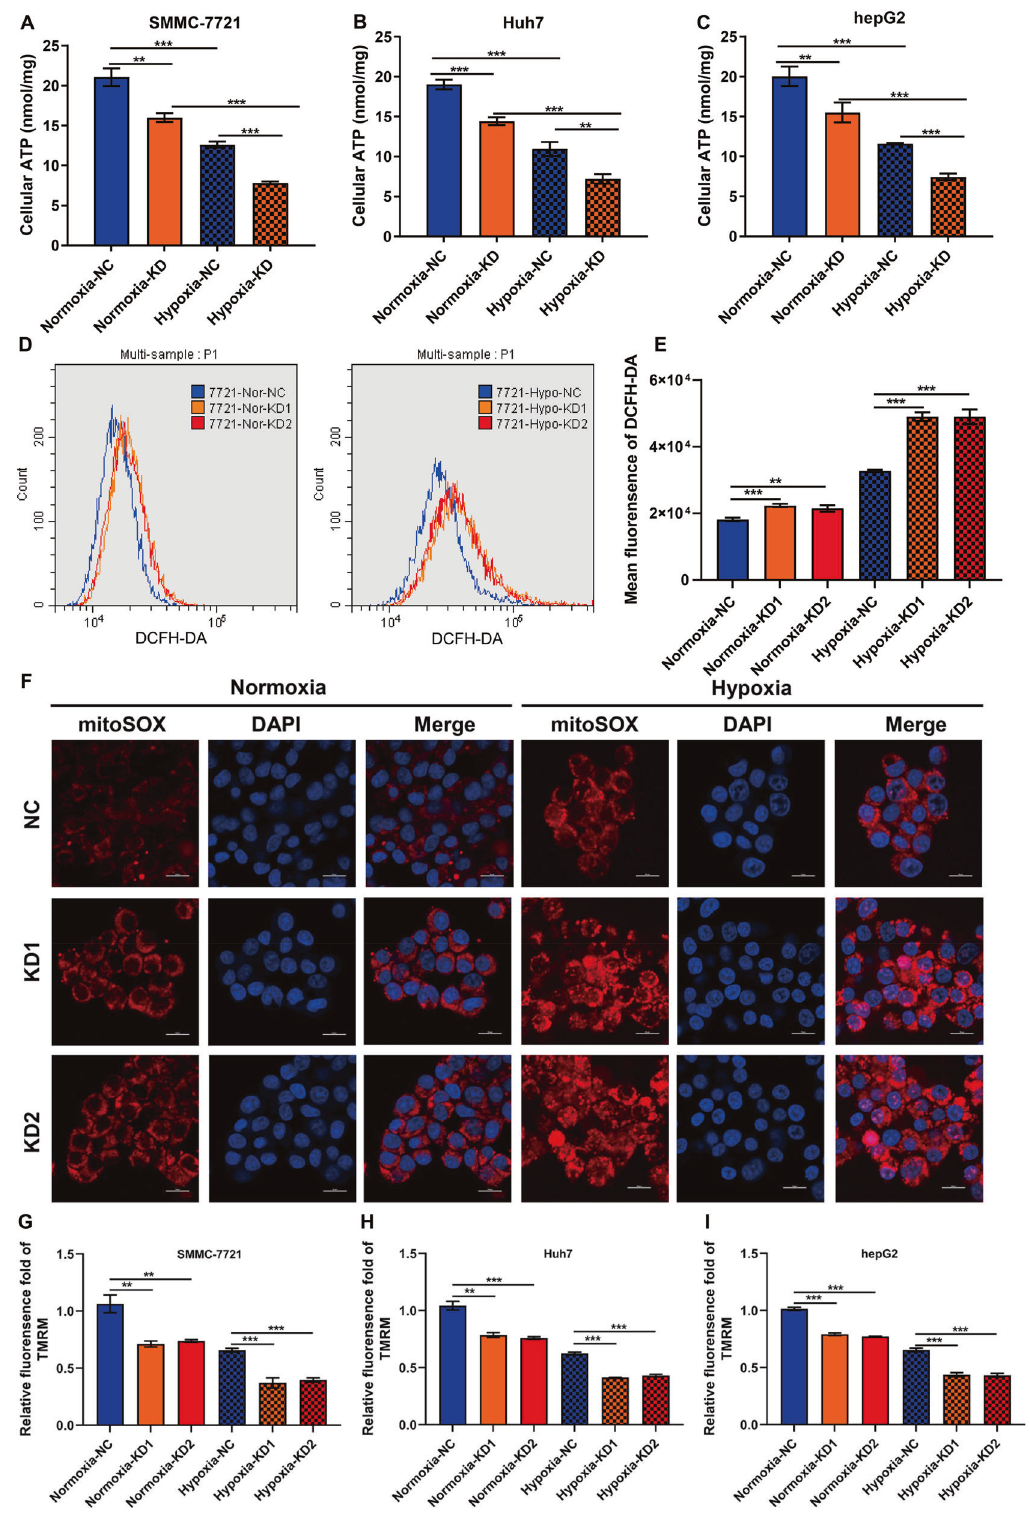
Fig. 3 HABON inhibited hypoxia-induced damage of mitochondrial function. A – C siHABON or siNC were transfected into SMMC-7721, Huh7, and hepG2 cells. The cells were cultured under normoxia or hypoxia for 24 h and the cellular ATP content was measured. D , E Determination of cellular ROS content in each group of SMMC-771 cells by DCFH-DA fl ow cytometry. F Perform MitoSox staining and mitochondrial ROS level in each group of hepG2 cells was visualized by confocal microscopy. G – I Mitochondrial membrane potential in each group of SMMC-771 cells was measured by TMRM fl ow cytometry and relative fl uorescence intensity was calculated. Error bars stand for mean ± SD. Three independent experiments, two-tailed Student ’ s t -test. * p < 0.05, ** p < 0.01, *** p < 0.001.